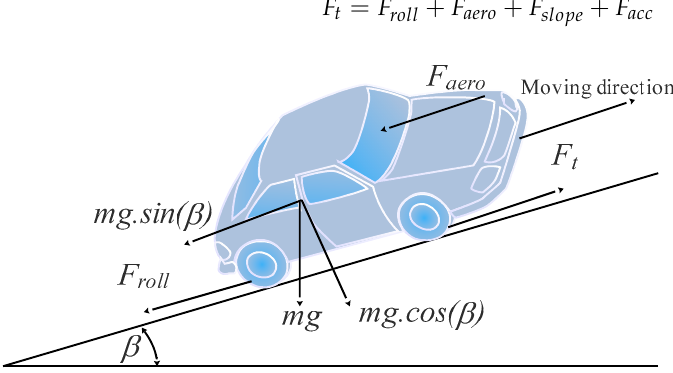
Figure 2. Force applied to the vehicle.